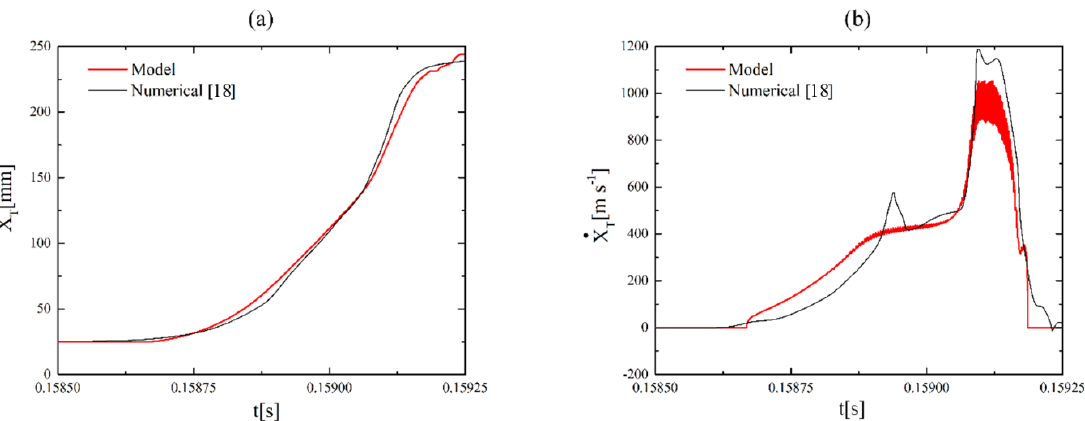
Figure 6. Comparison in terms of crack tip position versus time ( a ); Comparison in terms of crack tip speed versus time ( b ).